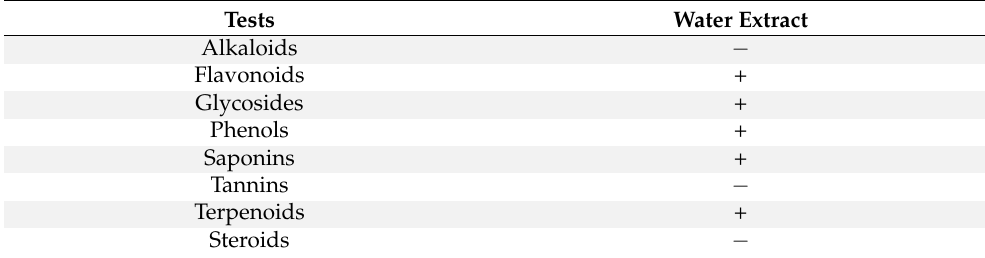
Table 1. Phytochemical Analysis of aqueous leaf extract of R. apiculata .